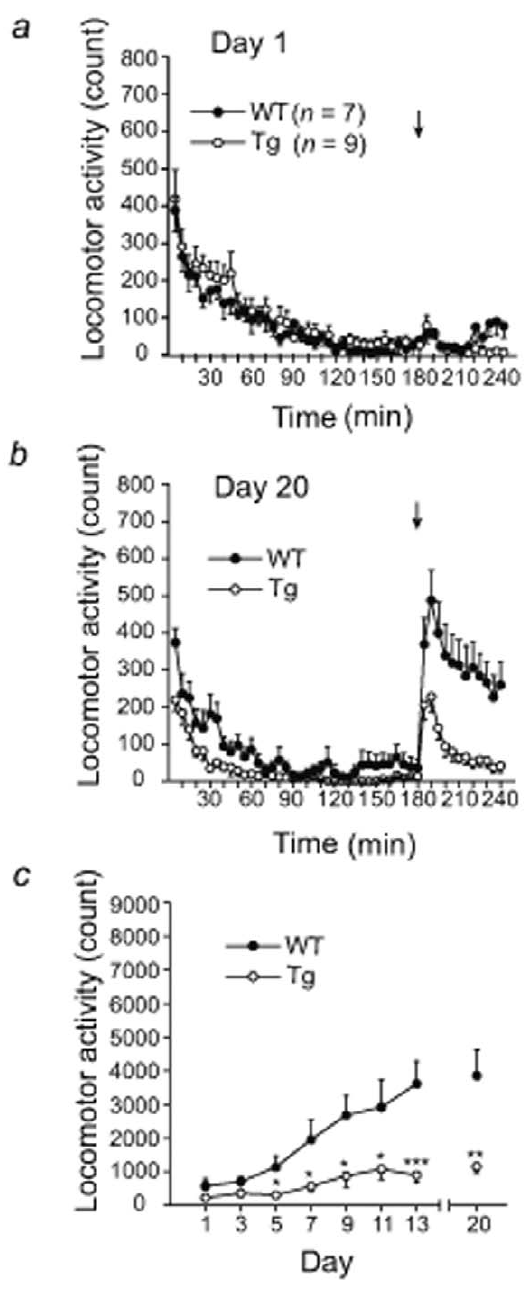
Figure 1. Spontaneous and METH-stimulated locomotor activ- ity in wildtype mice (WT) and ICER I-overexpressing mice (Tg). METH (1 mg/kg) was administered once per day on Days 1, 3, 5, 7, 9, 13, and 20 in WT ( n =7) and Tg ( n =9) mice. a . Time-course of spontaneous locomotor activity before and after METH administration on Day 1. The data are expressed as mean 6 SEM beam breaks in 5 min bins. The arrow indicates the start of a METH injection. b . Time-course of spontaneous locomotor activity before and after METH administration on Day 20. The data are expressed as mean 6 SEM beam breaks in 5 min bins. The arrow indicates the start of a METH injection. c . METH- induced locomotor sensitization. The data are expressed as mean 6 SEM beam breaks during the 60 min period after METH injection (1 mg/ kg) on Days 1, 3, 5, 7, 9, 13, and 20. * p , 0.05, ** p , 0.01, *** p , 0.001, significant difference in locomotor activity scores between WT and Tg mice.